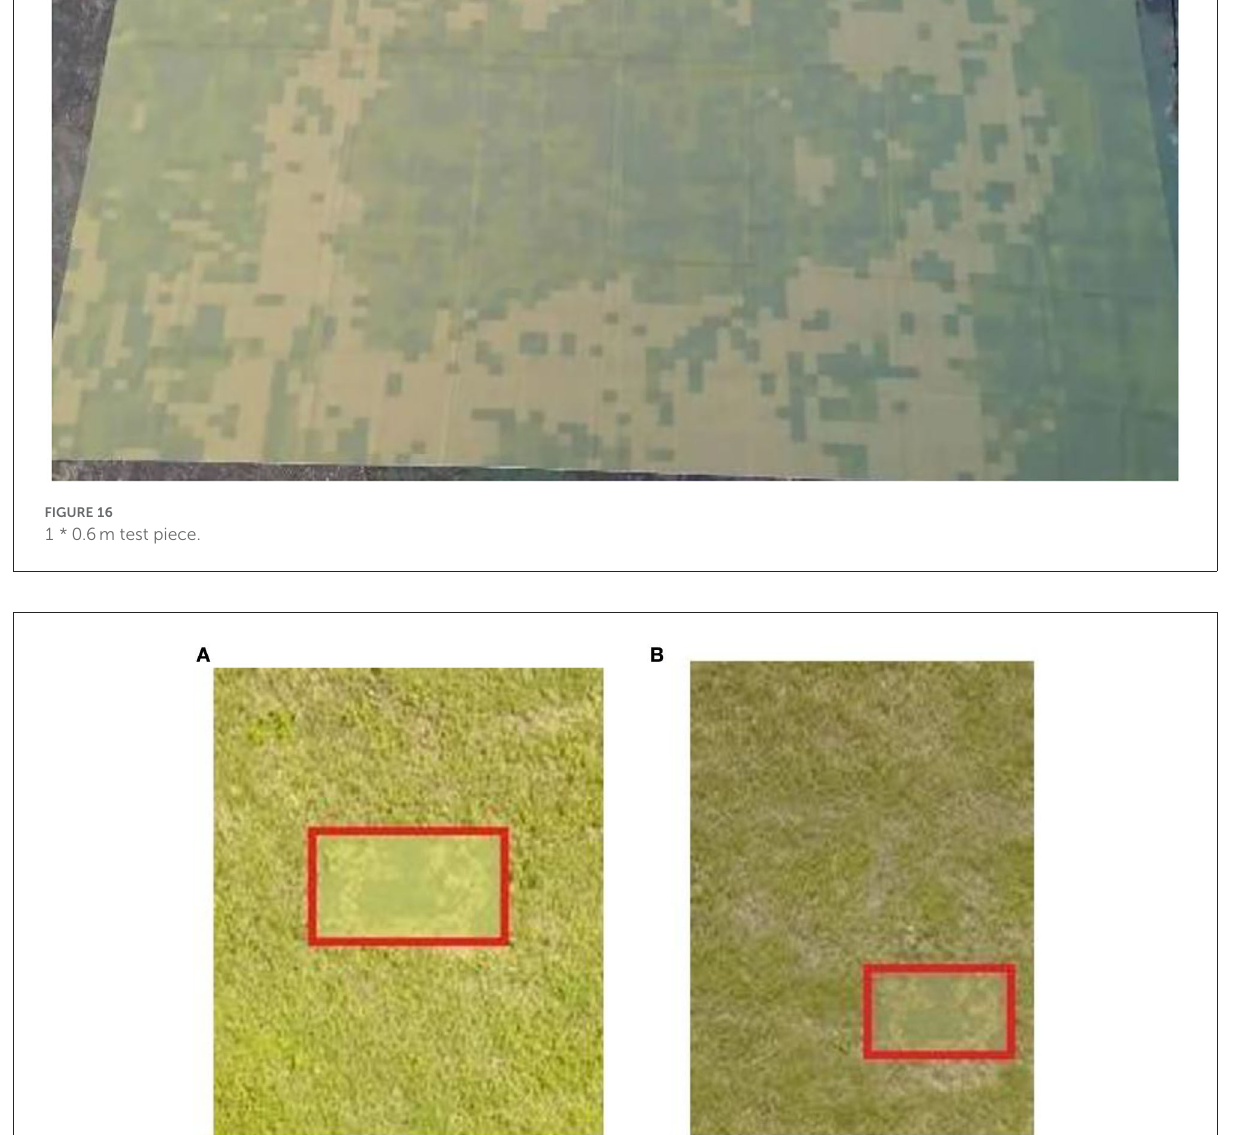
FIGURE17 Test pieces under different meteorological conditions. (A) Sunny, (B)